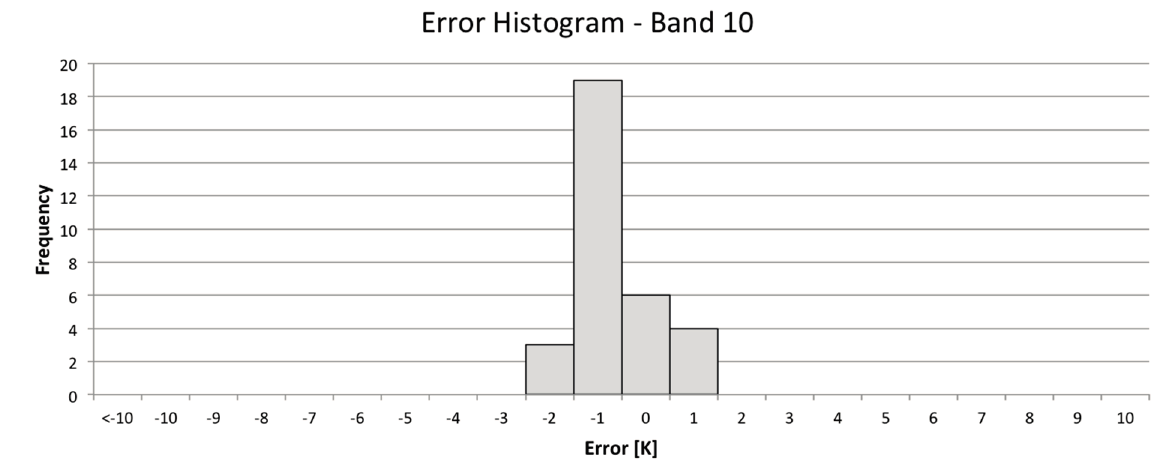
Figure 14. Histogram of errors for Landsat 8 band 10 including only cloud free